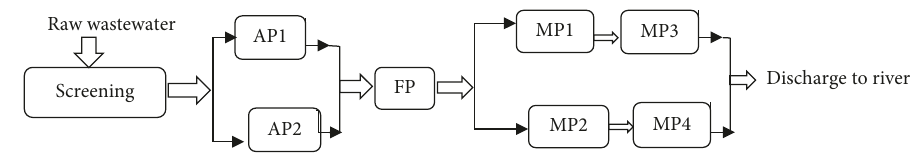
Figure 2: Schematic flow diagram of the WSP in Kito Furdisa Campus, Jimma University, Jimma town, Southwest Ethiopia, 2020.